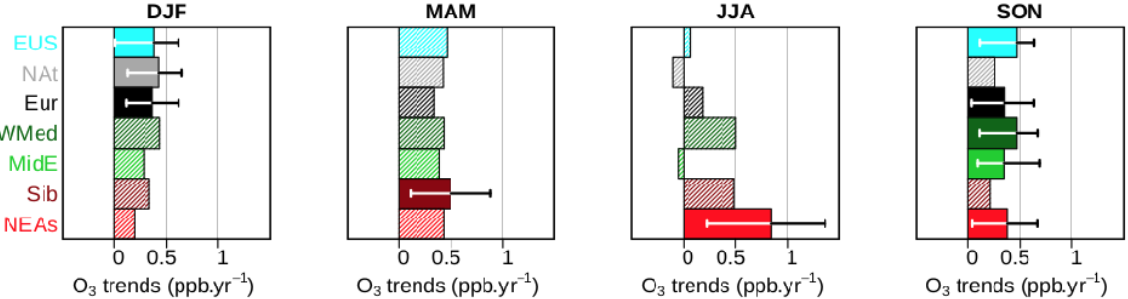
Figure 11. O 3 trends (ppbyr − 1 ) in the UT, in each season. For each significant trend, the error bars represent the 95% confidence interval. The insignificant trends are represented by hatched areas. The coloured labels correspond to the regions defined in Fig. 1.